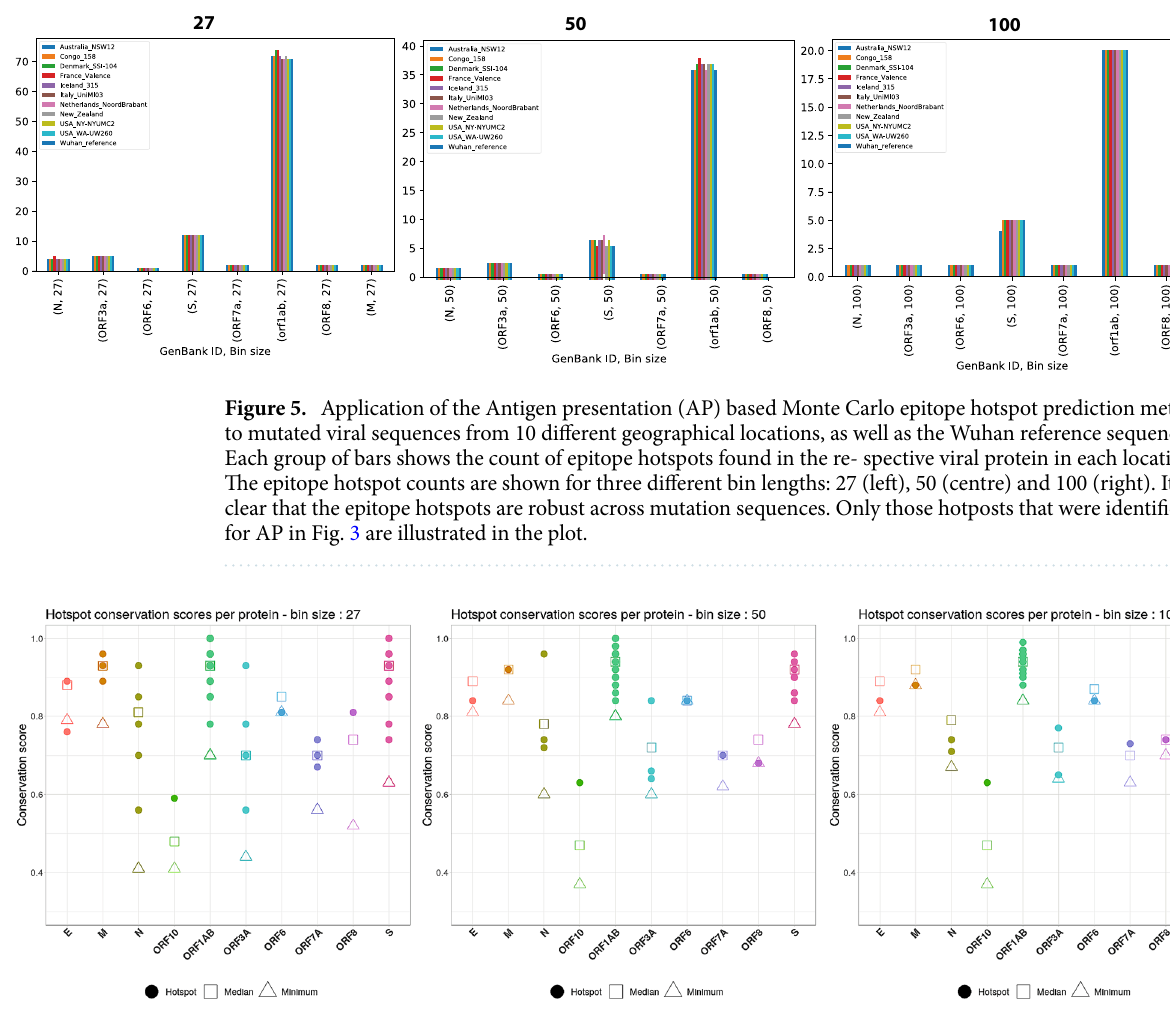
Figure 6. The scatter plots show the distribution of the hotspot conservation scores (Y-axis) for proteins in the viral genome (X-axis). Each plot con- tains the conservation scores of the hotspots identified based on immune presentation (IP), using different bin sizes: 27 (left), 50 (center), and 100 (right). A hotspot is represented by a filled coloured circle, while the median conservation score for a given protein is depicted by a hollow square. As a reference, upwards facing triangles show the minimum conservation score for that protein. Only hotspots with a conservation score above the median were taken for further